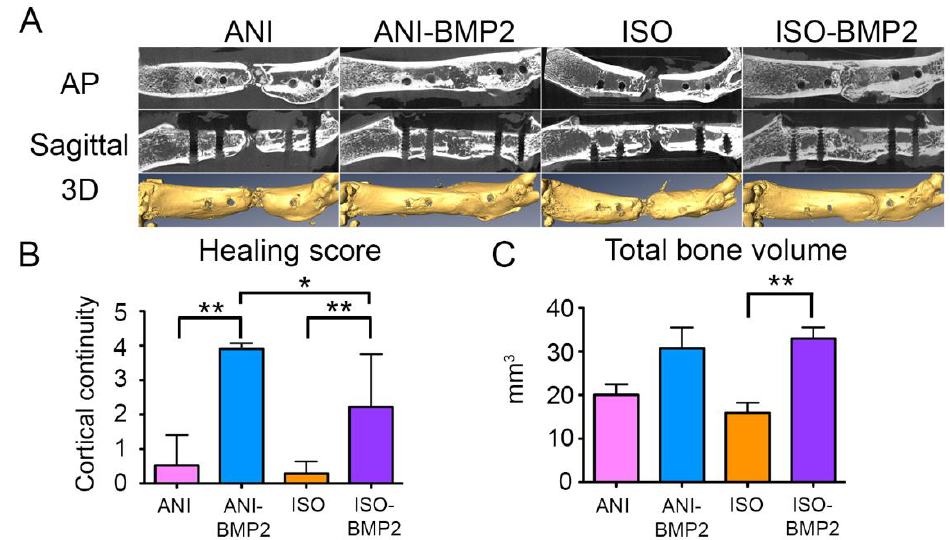
Figure 5. Micro computed tomography analysis of the reparative process. ( A ) Summary of the 3D reconstruction and its renderings. AP, apical plane; Sagittal, sagittal plane; ( B ) The cortical continuity of the samples was analyzed in two projections and quantified. *, p < 0.05; **, p < 0.01 by Kruskal–Wallis test ( p = 0.0001) and post-hoc Dunnett’s test; ( C ) The total bone volume was quantified from the 3D reconstructions. **, p < 0.01 by one-way ANOVA ( p = 0.0205) and post-hoc Tukey’s multiple